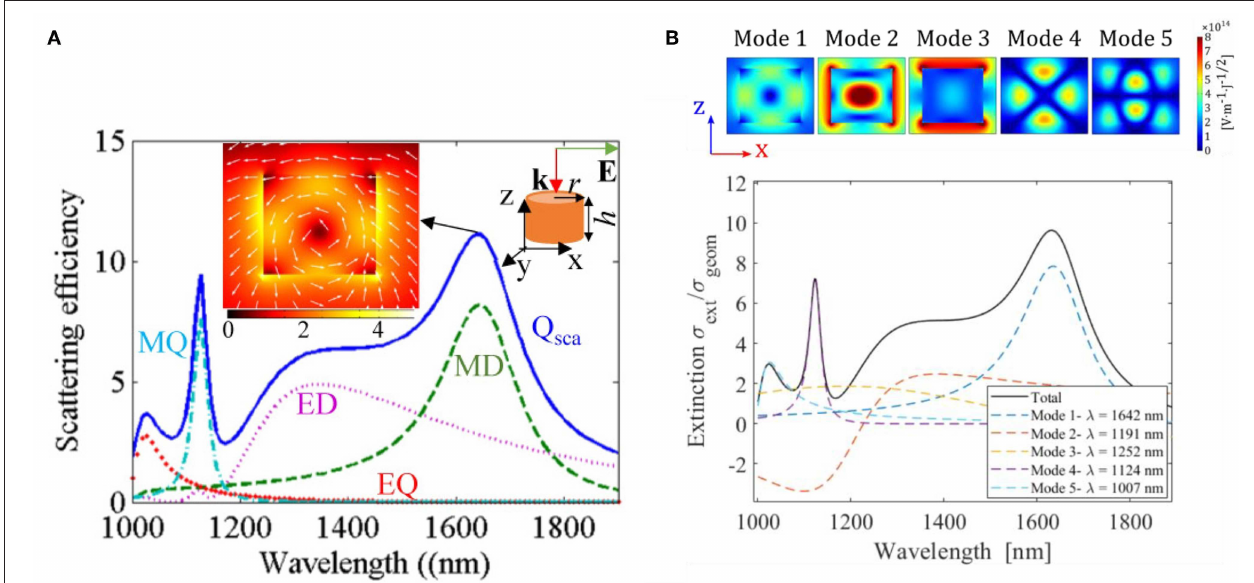
FIGURE 1 | AlGaAs nanocylinder scattering efficiency computed with COMSOL for radius r = 225nm and height h = 400nm. External excitation is approximated with a plane wave with the k vector parallel to the cylinder axis (see inset). Blue solid line represents total scattering, while dashed line is the expansion on spherical harmonics multipoles: electric and magnetic dipoles (ED and MD, respectively) and quadrupoles (EQ and MQ, respectively). Reprinted with permission from Carletti et al. [34]. (B) QNM expansion of AlGaAs nanocylinder linear scattering for the same geometry and excitation conditions as in (A) . Black solid line reports the total scattering, considering that just five QNMs. Colored dashed lines report the contribution of each QNM separately. Values in nm reported in the legend refer to the real part of the eigenfrequency of every mode. Inset: Electric field distributions in the xz plane of the five QNMs used for linear scattering